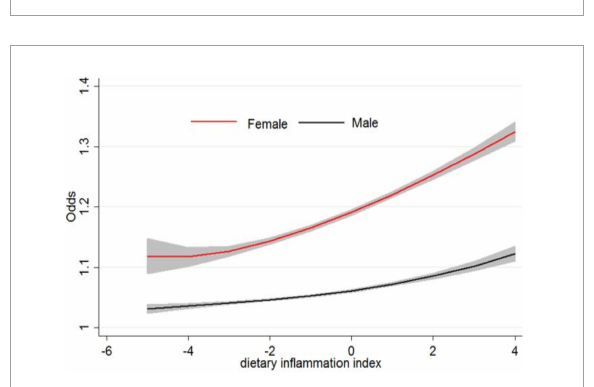
FIGURE1 Association of glomerular filtration rate and dietary inflammatory index.